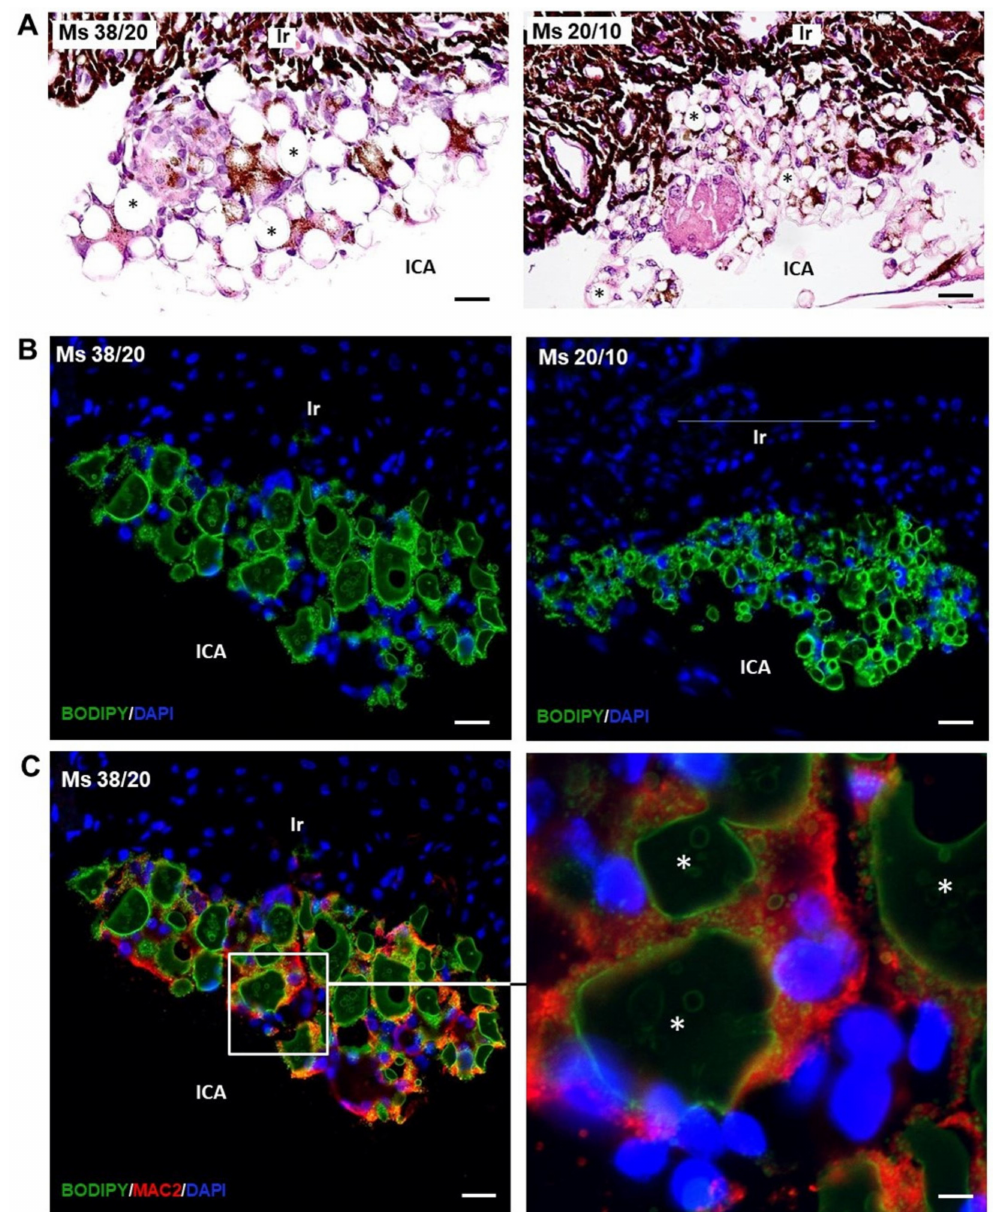
Figure 3. Identification of microspheres. ( A ) In Hematoxilin/Eosin-stained paraffin sections, microspheres (*) appeared transparent and colorless. They were surrounded by cells, sometimes containing black pigment. ( B ) Microspheres were specifically marked by boron-dipyrromethene (BODIPY) fluorescent dyes. ( C ) Double immunofluorescence using anti- Mac2 antibody, a specific marker of macrophages, showed that microspheres were surrounded by macrophages. Nuclei counterstained with Dapi. ICA: iridocorneal angle; Ir: iris; 38/20 and 20/10 µ m microspheres. Scale bar: ( A ) 21.58 µ m, ( B ) 18.49 µ m, ( C ) 18.49 µ